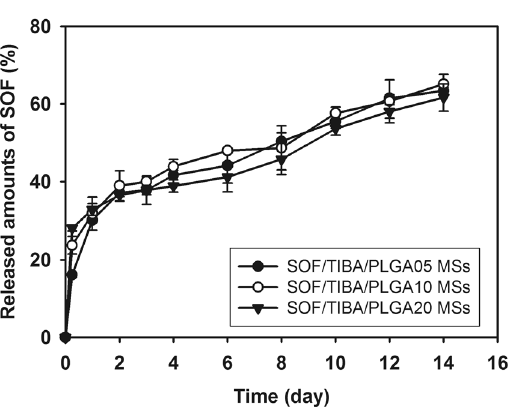
Figure 3. Drug release profile from SOF/TIBA/PLGA MSs (SOF/TIBA/PLGA05 MSs, SOF/TIBA/PLGA10 MSs, and SOF/TIBA/PLGA20 MSs) at pH 7.4. Each point indicates means ± SD ( n =